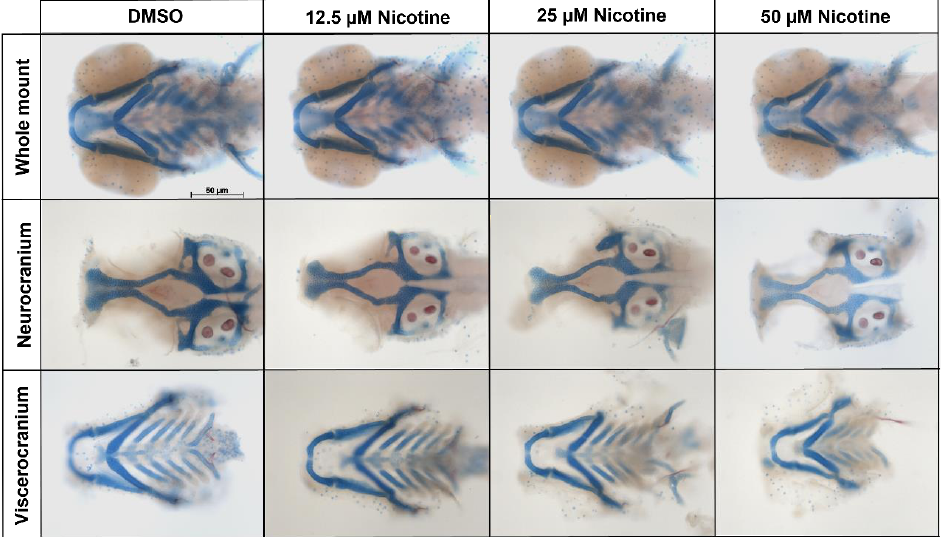
Figure 2. Embryonic nicotine exposure disrupts craniofacial development. Representative whole mount, neurocranial, and viscerocranial flat mount preparation after nicotine exposure from 6 hpf to 4 dpf. Decreases in the size of the craniofacial skeleton were observed as nicotine concentration increased. All images were captured at 10× magnification. Scale bar 50 µm.